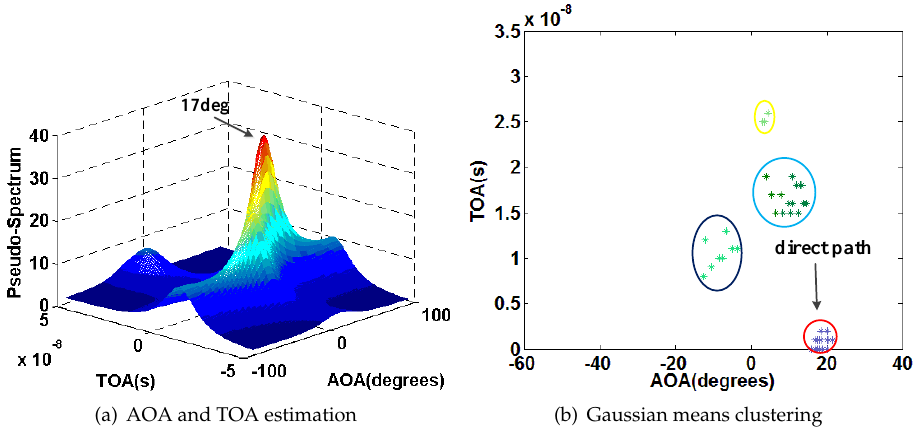
Figure 16. Results of AOA and TOA estimation and the related Gaussian means clustering at the AP2.